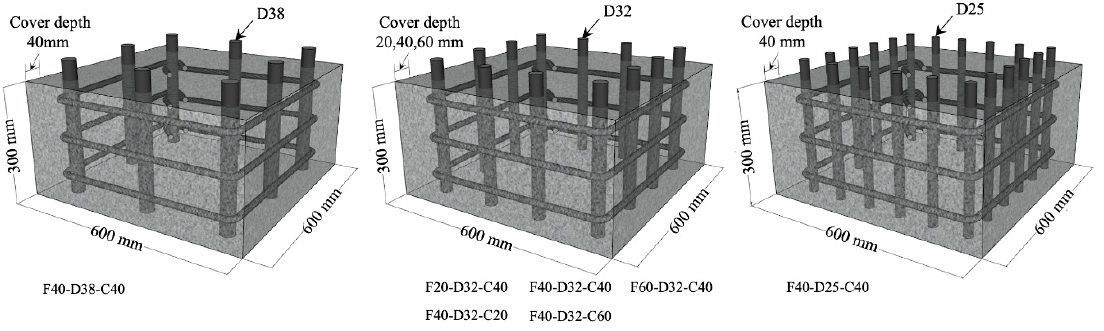
Figure 1. Reinforced concrete (RC) specimens and the arrangement of the reinforcing bars.